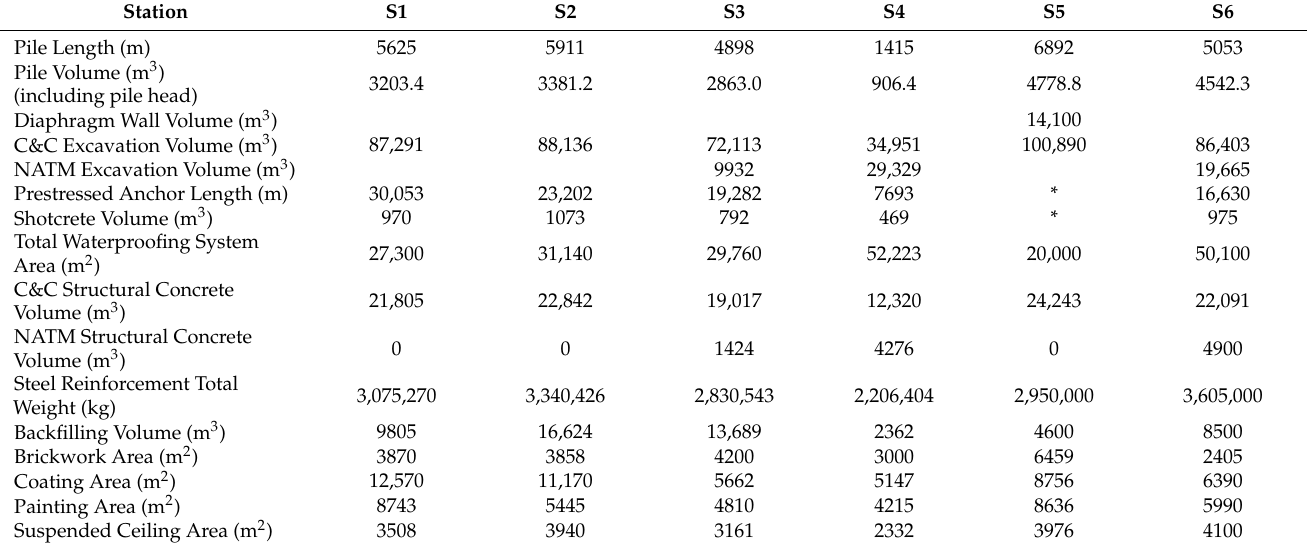
Table 3. Material quantity data.